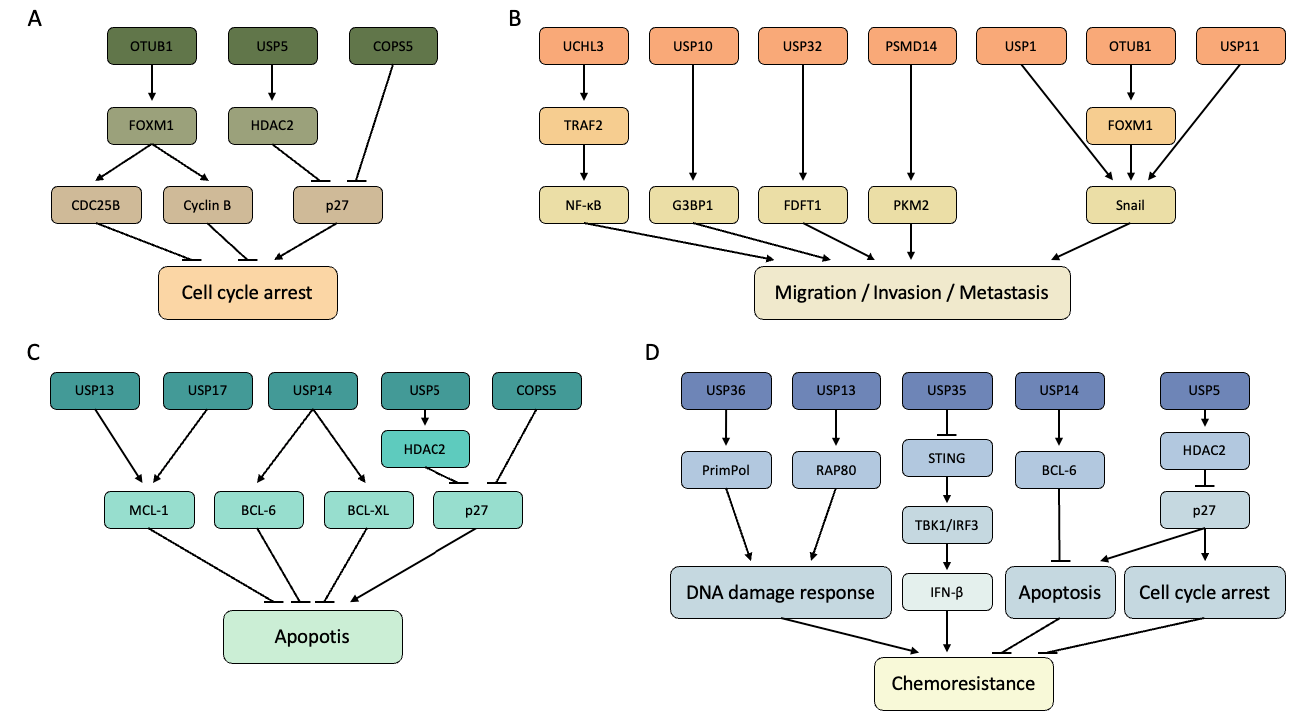
Figure 2. DUBs, substrates, and their functions. ( A ) DUBs and substrates associated with cell cycle arrest. ( B ) DUBs and substrates associated with migration, invasion, and metastasis. ( C ) DUBs and substrates associated with apoptosis. ( D ) DUBs and substrates associated with DNA damage response and chemoresistance. The arrows from the DUBs to the substrates indicate that the binding between them is confirmed, and the stability of the substrate is controlled by DUBs.